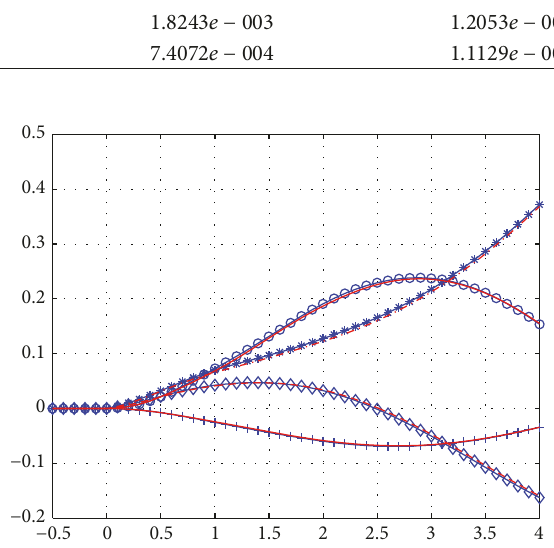
Figure 2: Numerical solutions by using the two methods for solving